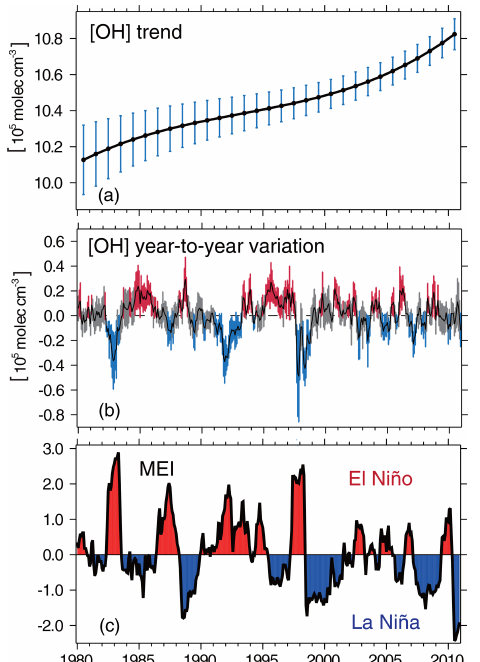
Figure 1. (a) Annual global tropospheric mean OH concentration ([OH] GM-CH , CH 4 reaction weighted) with year-to-year varia- 4 tions removed (represents the OH trend) simulated by CCMI mod- els. The black line is the multimodel mean, and associated error bars are standard deviations of different model results (also for panel b ). (b) Anomaly of detrended and deseasonalized monthly mean [OH] GM-CH (represents the year-to-year variations in OH). 4 Red bars indicate that the multimodel-simulated [OH] GM-CH has 4 statistically significant ( P < 0.05) positive anomalies; blue bars in- dicate statistically significant negative anomalies; and grey bars in- dicate statistically nonsignificant anomalies. (c) Bimonthly Multi- variate ENSO Index (MEI.v2,